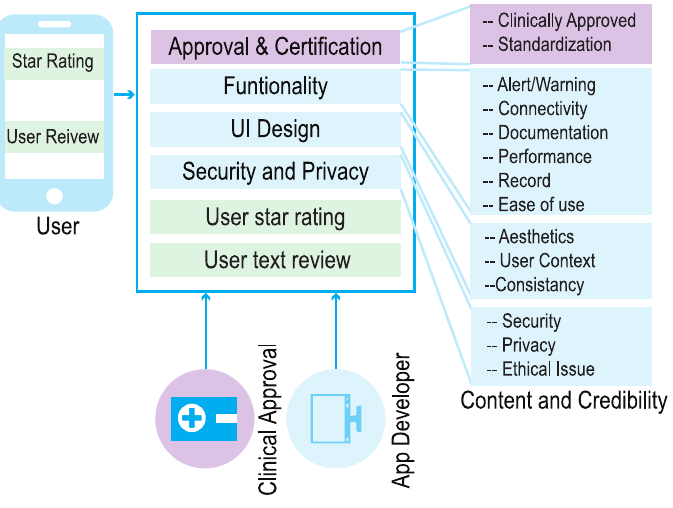
Fig 3. Relationship between input parameters and model parameters.